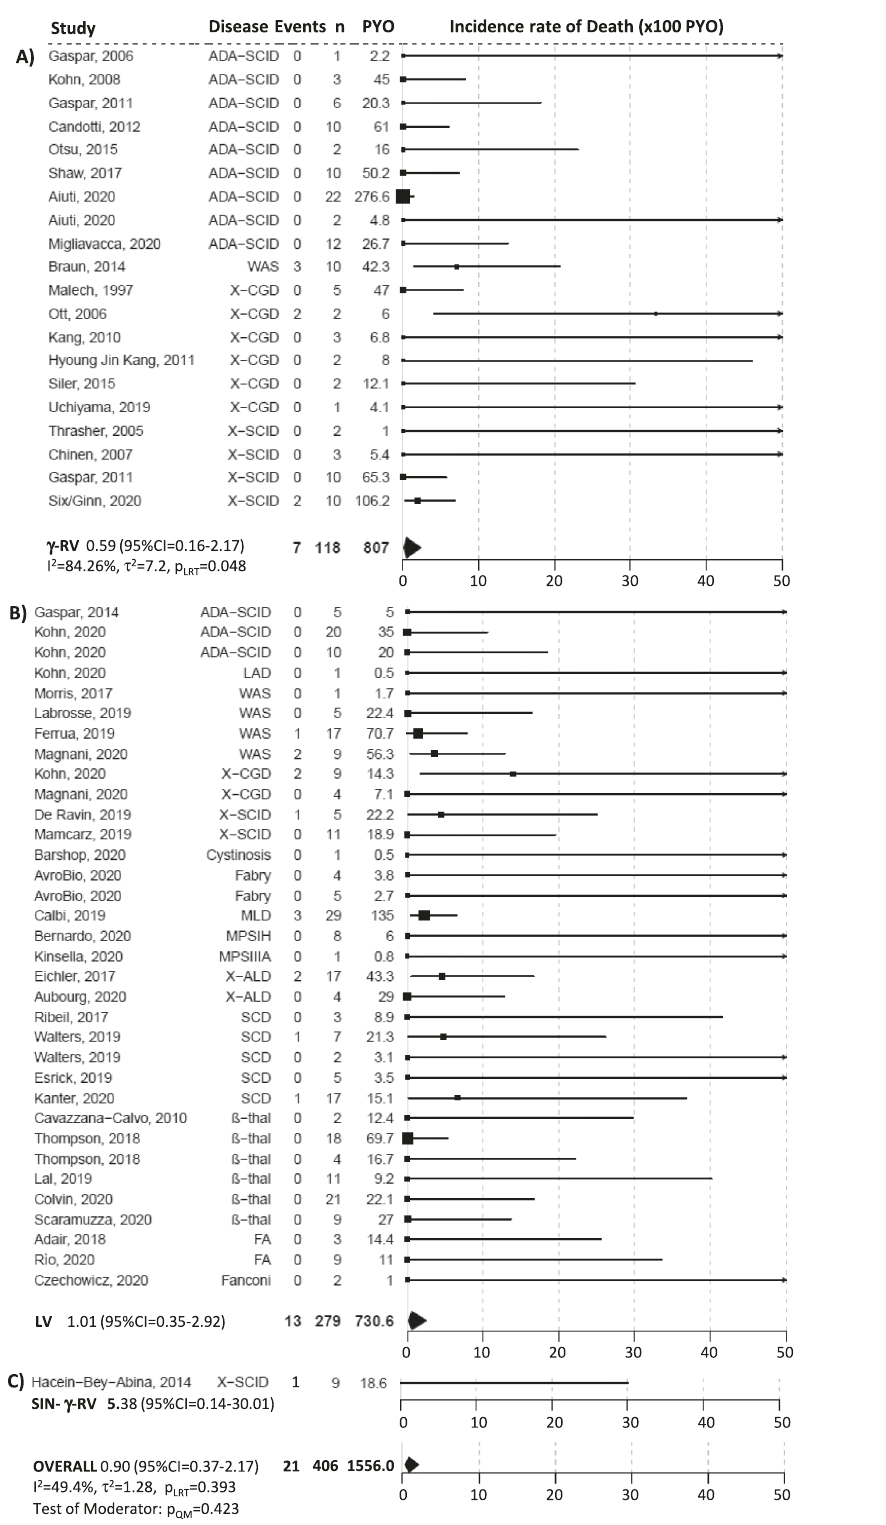
Fig. 2 Forest plot of the incidence rate of mortality by vector type, i.e., (A) γ RV, (B) LV, (C) SIN- γ RV, and overall. The squares indicate the incidence rate of mortality and their size re fl ects the study sample size, while the horizontal lines represent 95% Con fi dence Intervals (CI). The diamond denotes the summary effect size from the random-effects model for all or subgroups of studies (from a meta-regression model), and the width of the diamond depicts the overall 95% CI. The indices of heterogeneity (I 2 and τ 2 ) refer to the overall analysis or to the single subgroups, and p LRT is the p value for the test of residual heterogeneity, while p QM refers to the test on vector type as moderator. All tests were two-tailed. Source data are provided as a Source Data fi